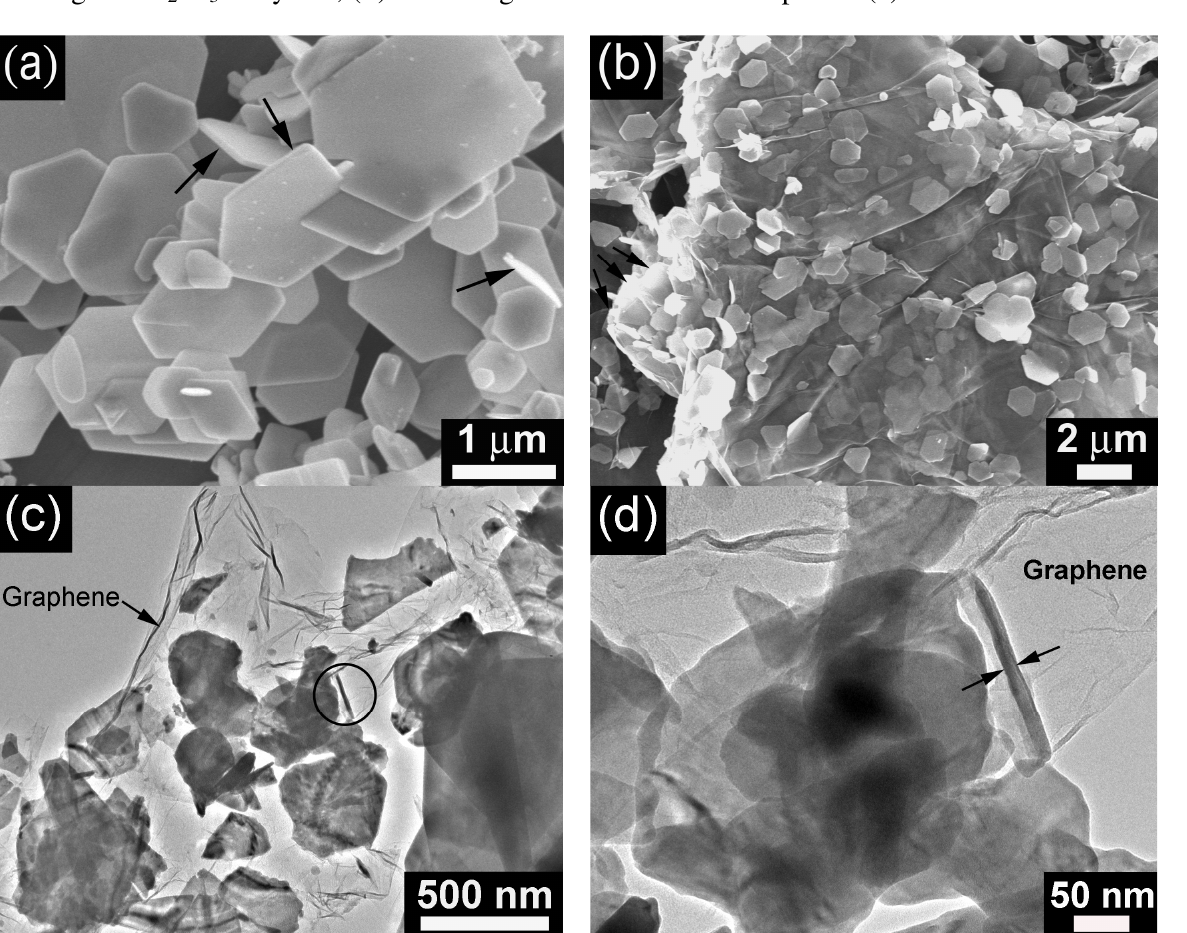
Te ; ( b ) SEM image of Bi 2 3